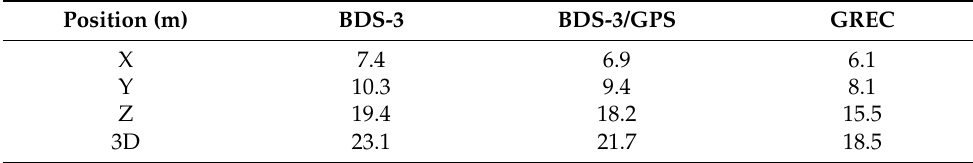
Figure 17. Differences between BDS SPP and the nominal HEO. Table 10. RMS of Position with different system combinations.